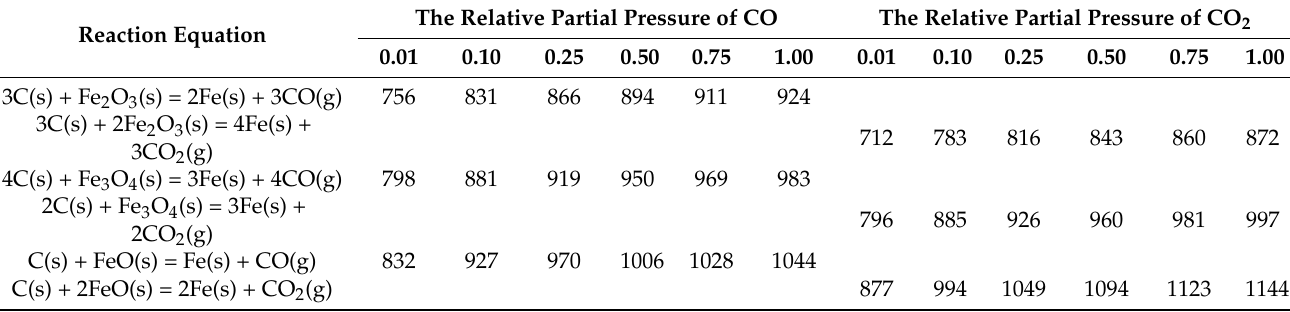
Figure 4. The equilibrium relative gas partial pressure in reduction reactions between carbon and iron oxides with single gas product generation: ( a ) CO global; ( b ) CO local; ( c ) CO 2 global; ( d ) CO 2 local. Table 3. The critical reaction temperature of reduction reactions between carbon and iron oxides with single gas product generation at one atmosphere